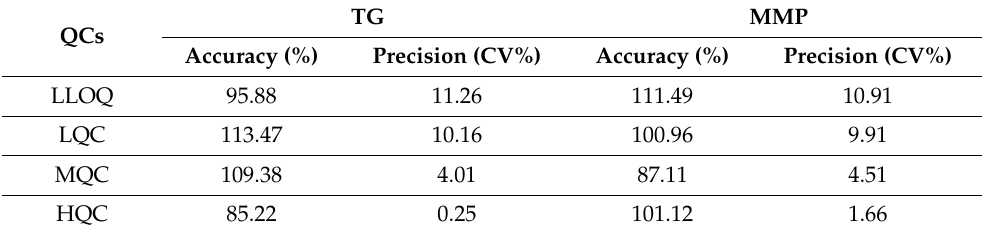
Table 10. Evaluation of stability of TG and MMP after 30 days, represented as accuracy and precision values, in the biological matrix.